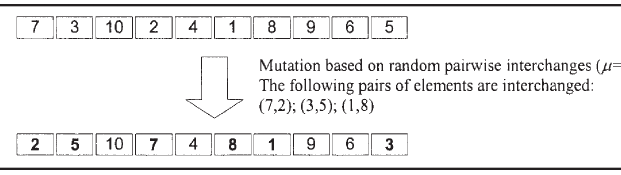
Figure 11. Example of